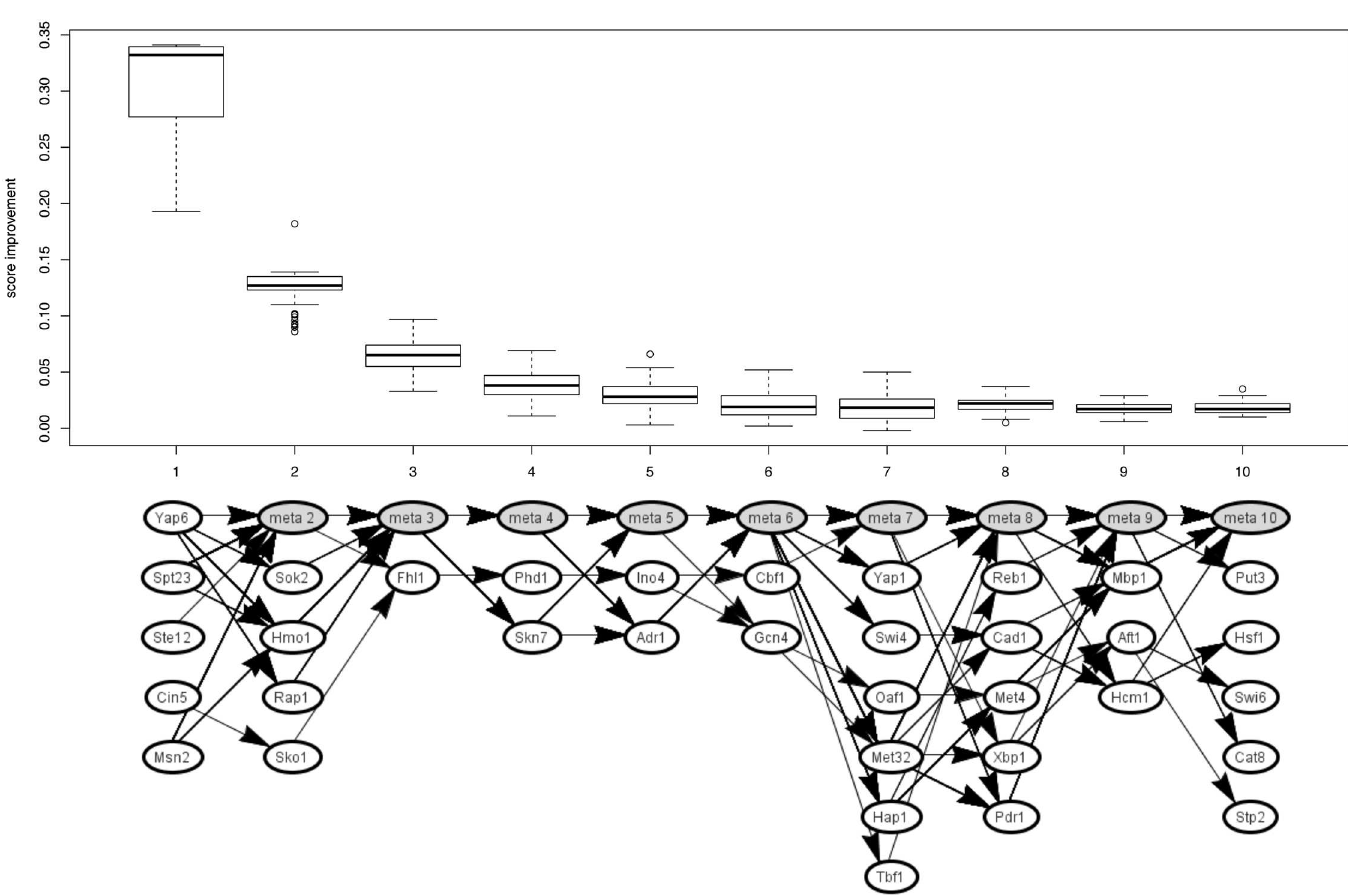
Fig 5. Variability of the 10% best Act-A * solutions. The graph (bottom) shows the active TFs in these solutions. Each path in the graph correspondsto one solution. The position indicates the A * step in which the respective TF is added to the solution. TFs that were added in another solution at an earlier position are collapsedinto meta nodes. The boxplot above shows the relative score improvements of the TFs at the given position. Only the 14 shown TFs are used in the first five positionsto explain the majority of the